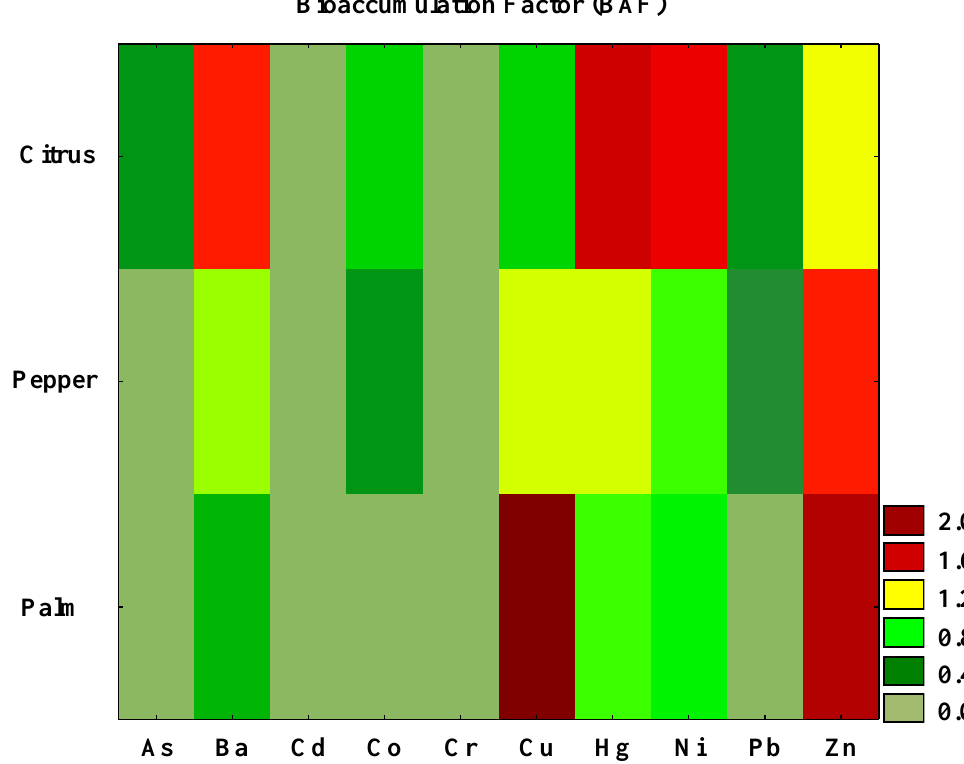
Figure 3. Bioaccumulation factors based on the average concentration of PTEs in plant tissues of the citrus, black pepper and oil palm cultivation areas.